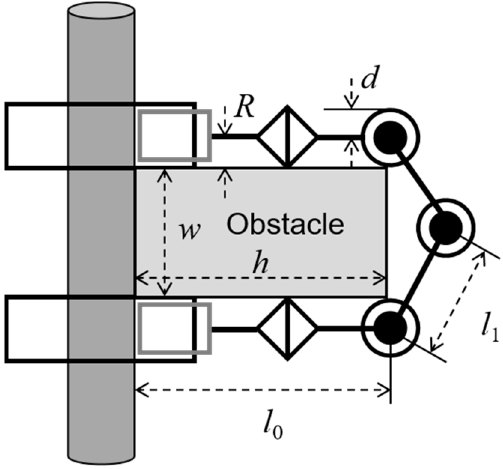
Figure 16. Ability analysis of overcoming obstacles.